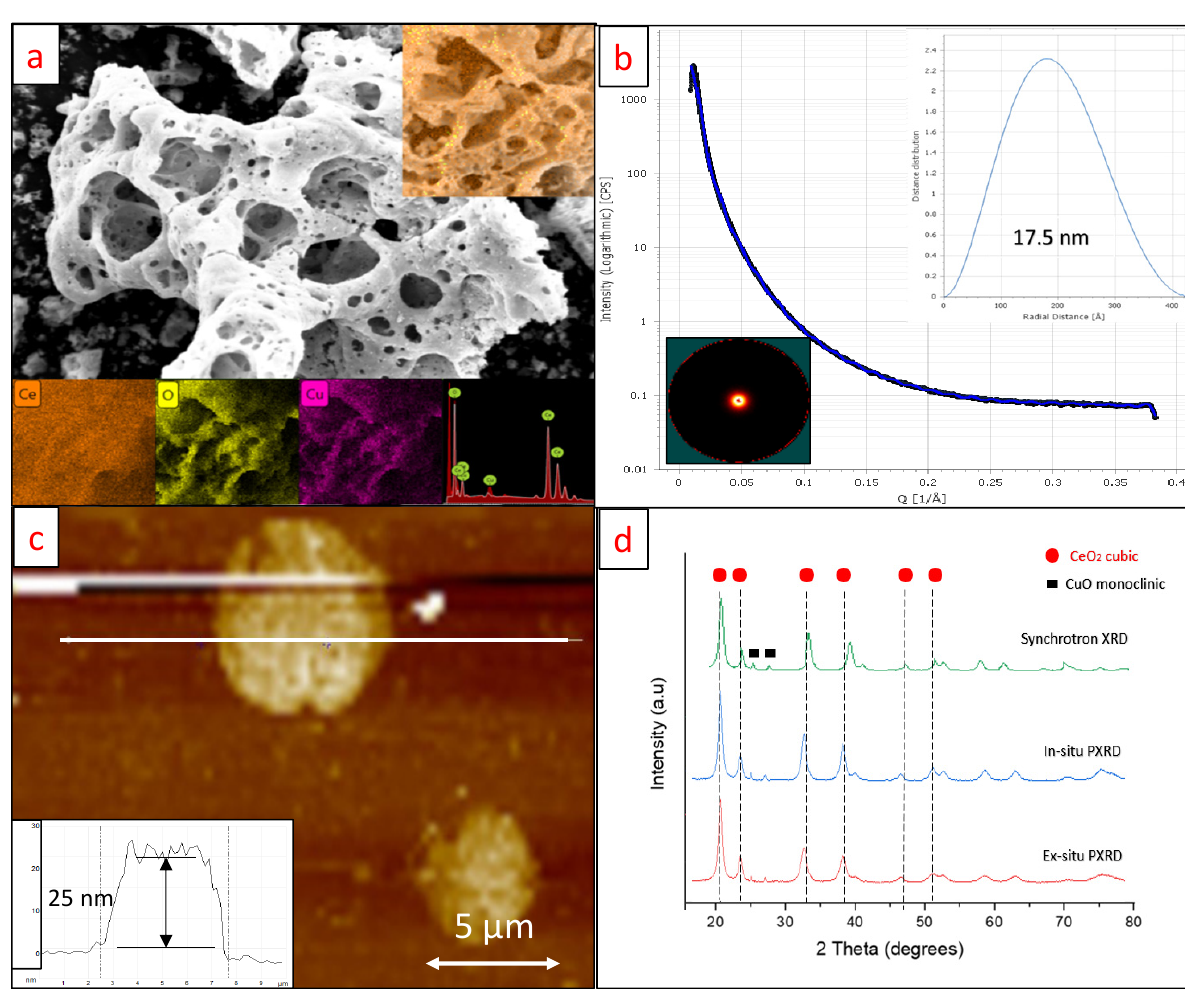
Figure 1. ( a ) Morphology of CuO/CeO 2 at 5000 × magnification (insert: enlarged cross-section area Fig.1: a) Morphology of CuO/CeO at x5000 magnification (insert: enlarged cross-section area at x20,000 magnification); b) SAXS analysis: Pair distance distribution at 20,000 × magnification); ( b ) SAXS analysis: pair distance distribution function analysis; ( c ) lateral 2 function analysis; Lateral height analysis using AFM (Insert: The height/roughness of the catalyst); and d) PXRD analysis of the catalyst. height analysis using AFM (insert: height and roughness of the catalyst); and ( d ) PXRD analysis of the